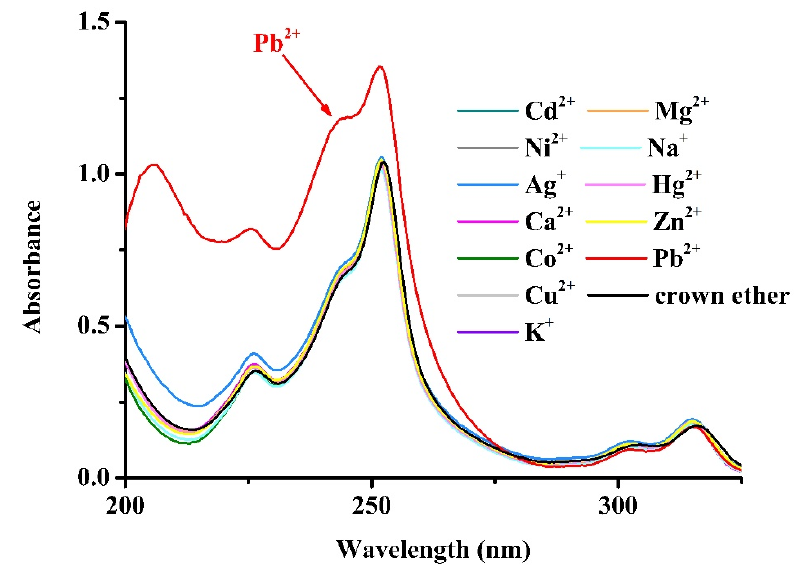
Figure 2. UV/Vis spectra of acridono-18-crown-6 ligand rac - 4 in the presence of 10 equivalents of metal salts.